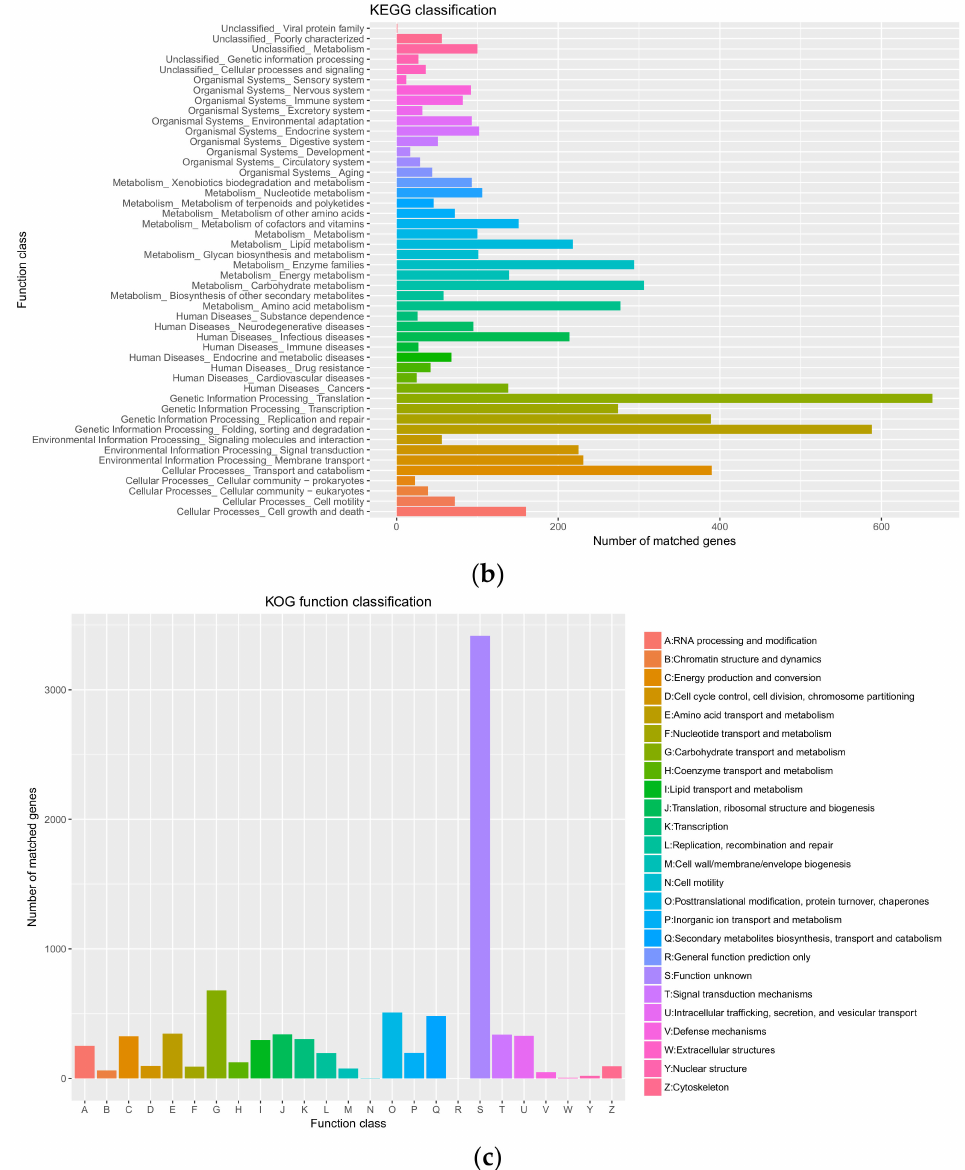
Figure 3. Functional annotation of strain SPS-2 genes encoding the proteins: ( a ) Gene Ontology (GO) analysis; ( b ) Kyoto Encyclopedia of Genes and Genomes (KEGG) analysis; ( c ) EuKaryotic Orthologous Group